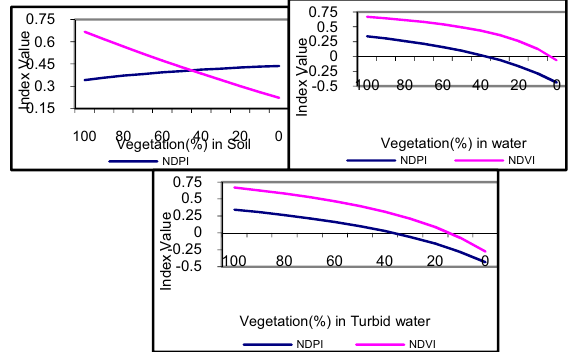
Figure 5 Sensitivity analysis - Plot of the spectral indices as a function of vegetation fraction contribution to the total reflectance-